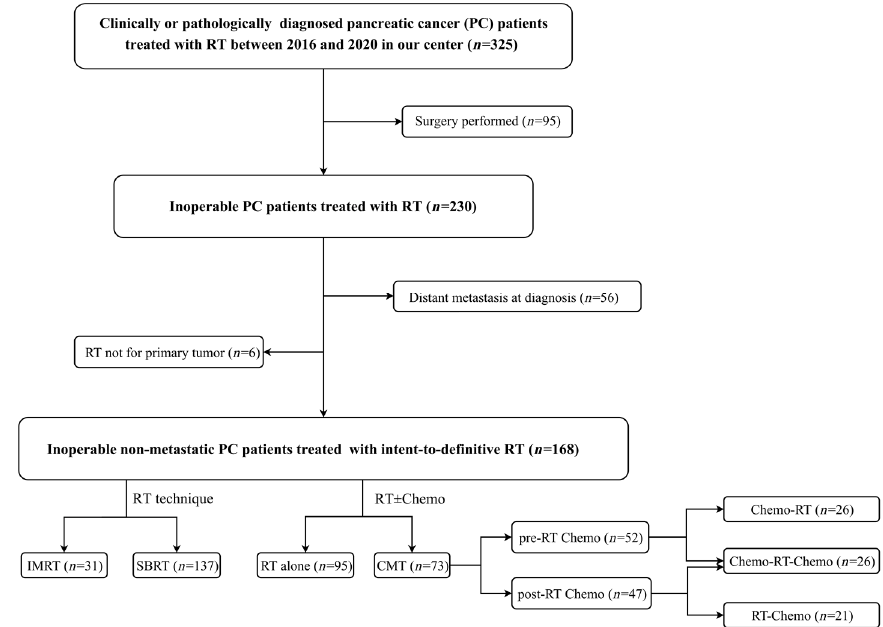
Figure 1. Flow chart of study enrollment and exclusions.